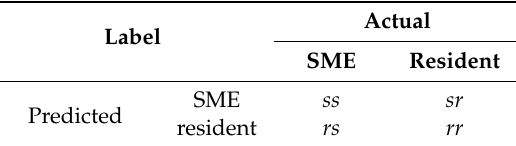
Table 4. Confusion matrix of case 2.